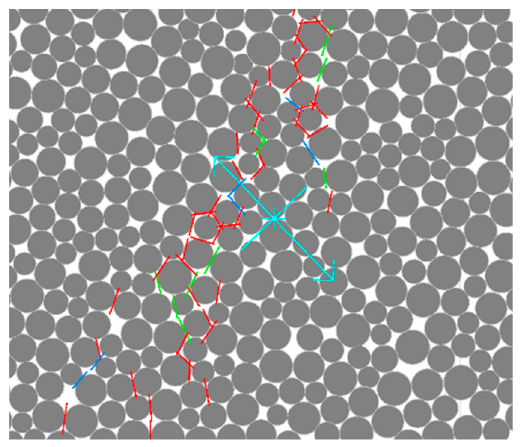
Figure 3. Schematic diagram of the principal strain rate tensor. (The red, green and blue micro-cracks represent tensile micro-cracks, tensile-shear micro-cracks, and compressive-shear micro-cracks, respectively, and the principal strain tensor is denoted by two sets of light blue lines with arrows).